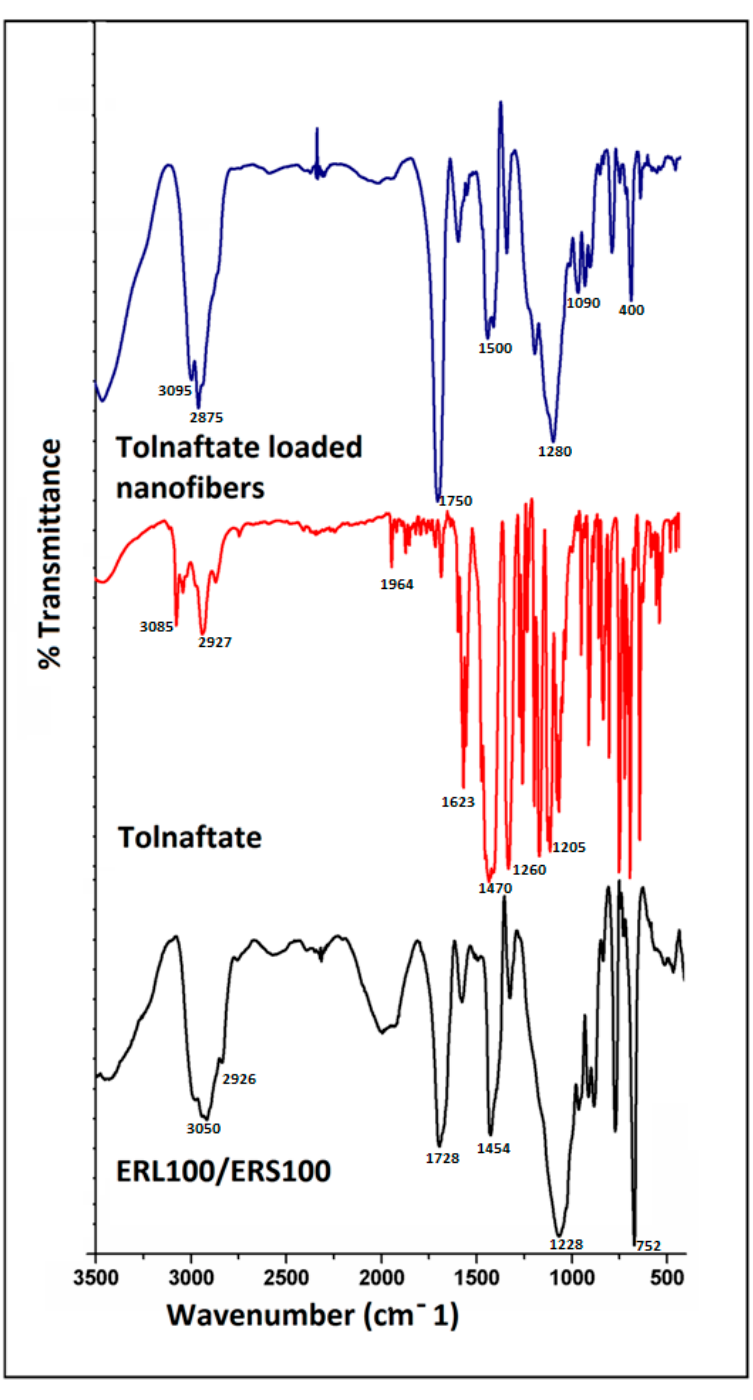
Figure 3. Comparative ATR-FTIR depicting specific peaks of functional groups present in the blend of ERL100/ERS100, tolnaftate, and tolnaftate-loaded nanofibers.